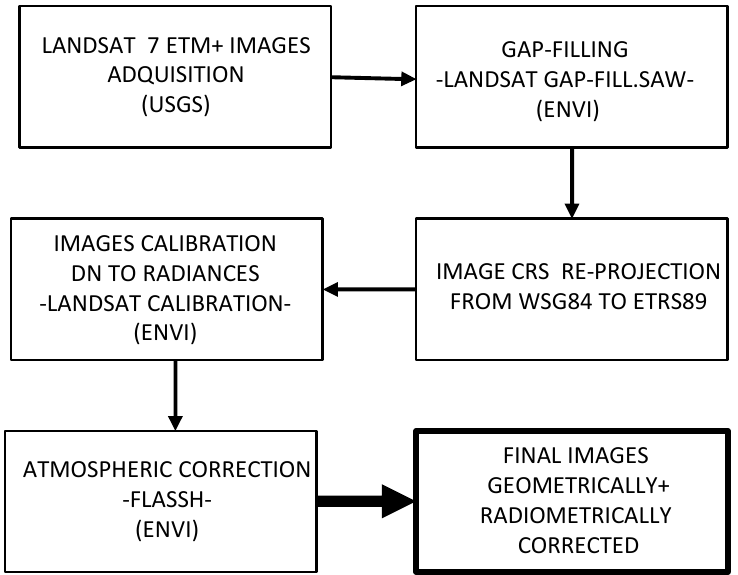
Figure 2. Preprocessing of satellite images.